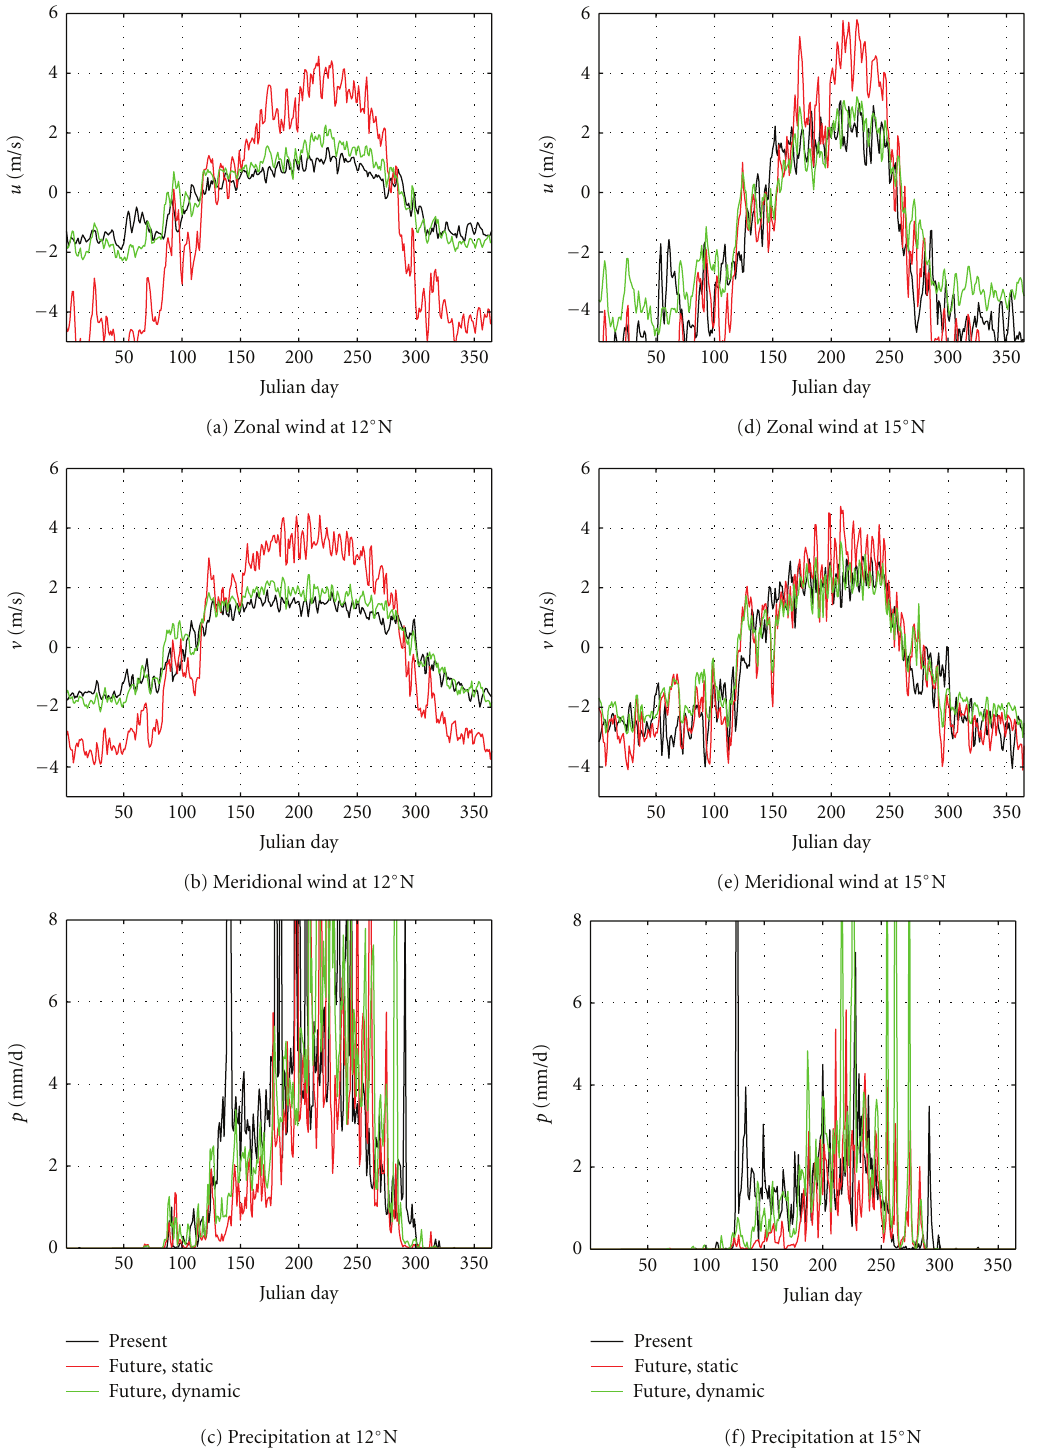
Figure 5: Climatology of daily wind and daily rainfall at 12 ◦ N and 15 ◦ N, averaged over 5 ◦ W-5 ◦